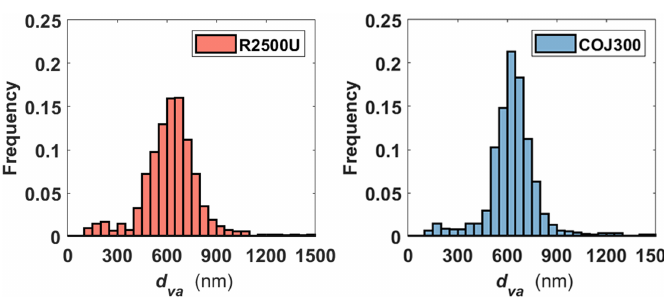
Figure A7. Vacuum aerodynamic diameter ( d va ) derived from PALMS for 400nm R2500U and COJ300 (Cziczo et al., 2006).